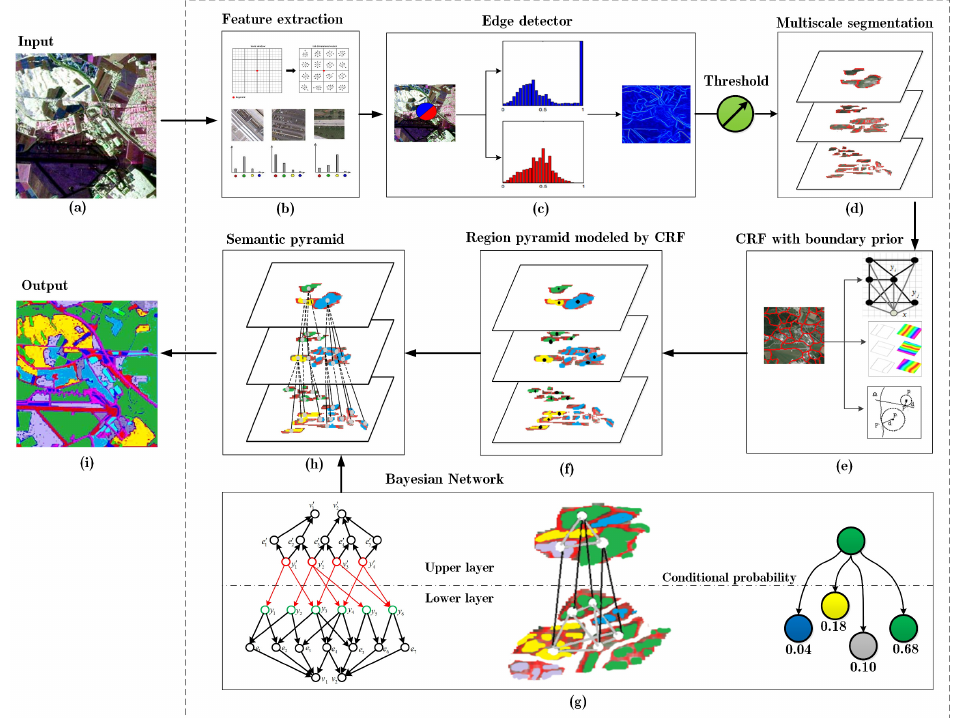
Figure 2. Framework of the proposed method. ( a ) Input SAR image; ( b ) feature extraction, including intensity, polarization and texture features; ( c ) edge detection; ( d ) region pyramid construction based on multiscale segmentation; ( e ) conditional random field with boundary prior knowledge; ( f ) the region pyramid modeled by CRF; the spatial relationships are formed by CRF; ( g ) causal connections between adjacent layers are captured by the Bayesian network; ( h ) semantic pyramid based on the CRF and BN model; ( i ) classification